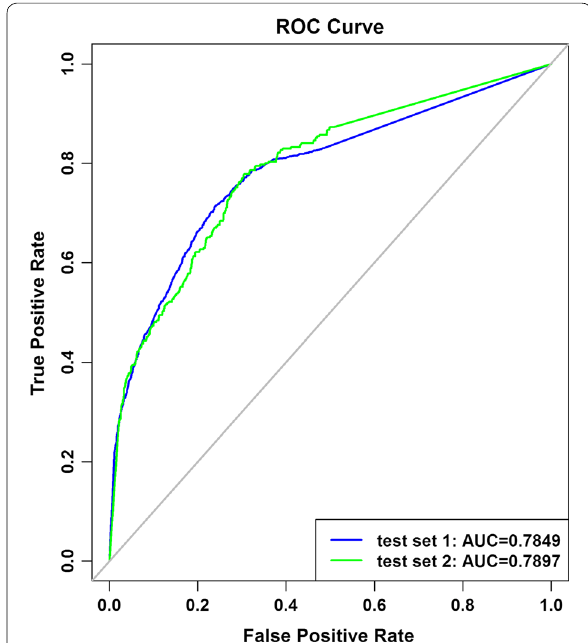
Fig. 4 ROC curve of SOMs predictions for test set 1 ( blue ) and test set 2 ( green ). Test set 1 is the internal test set that contains 425 different randomly selected substrate molecules from the metabolic reaction dataset. Test set 2 is the external test set that contains 173 com- pounds and was previously compiled by Zaretzkiet et al. [16]